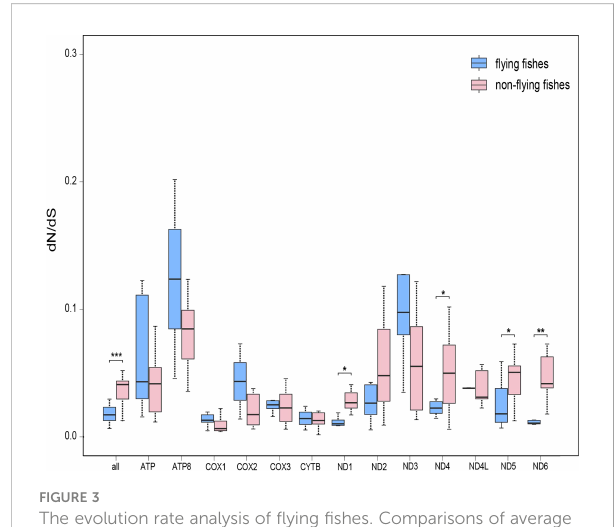
FIGURE 3 The evolution rate analysis of fl ying fi shes. Comparisons of average dN/dS ratios for 13 individual protein-coding genes between fl ying fi shes and non- fl ying fi shes. Note: *0.01 <P <0.05, **0.001 <P <0.01.